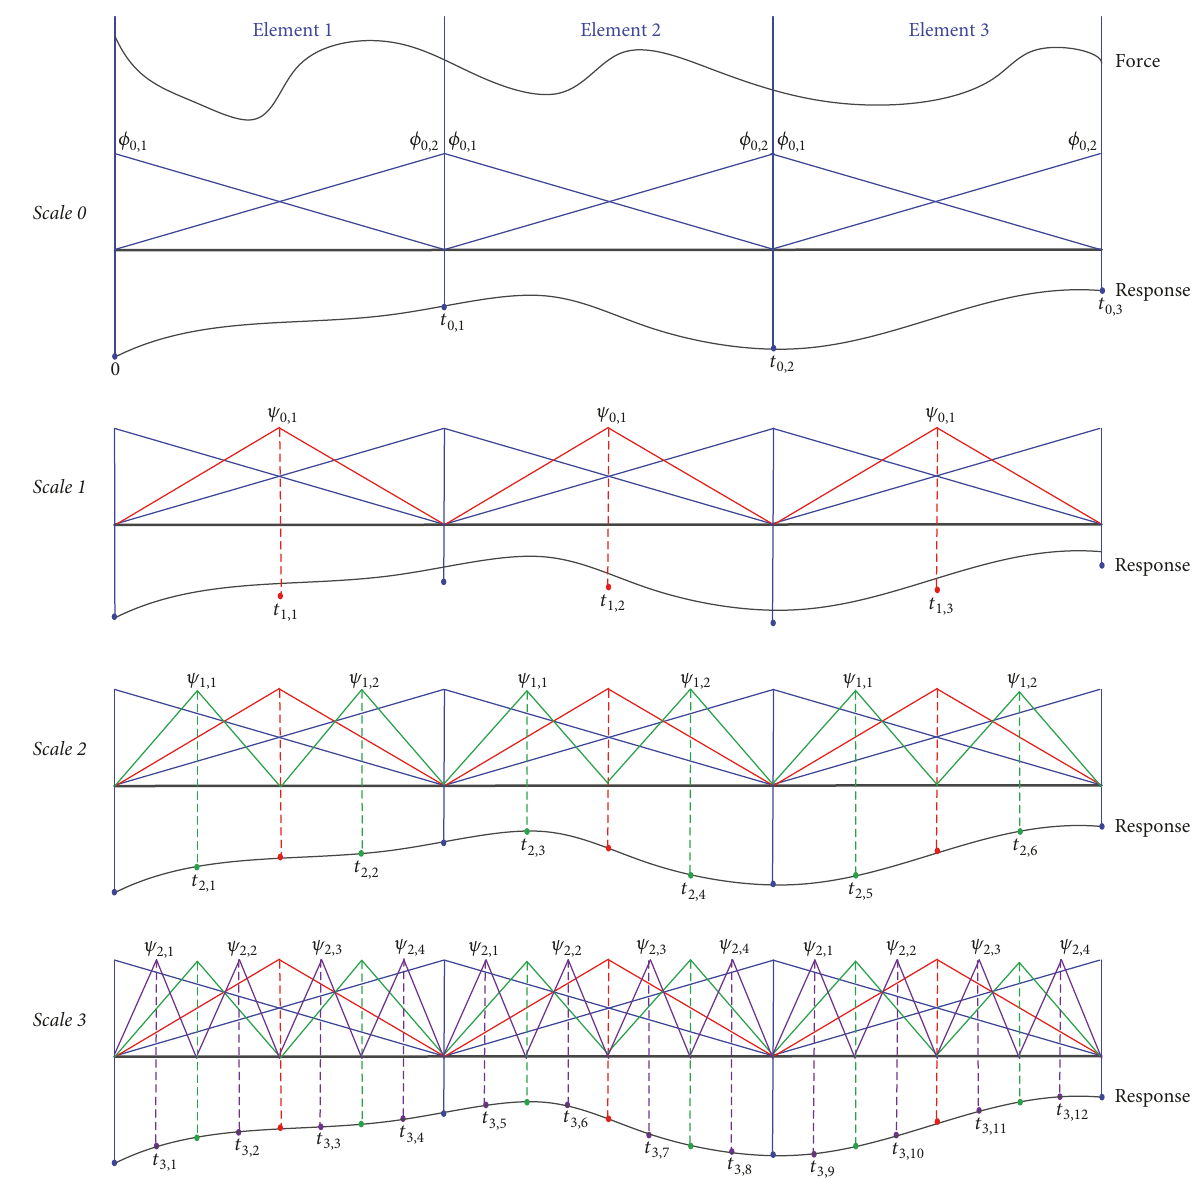
Figure 3: Example of the adaptive force reconstruction